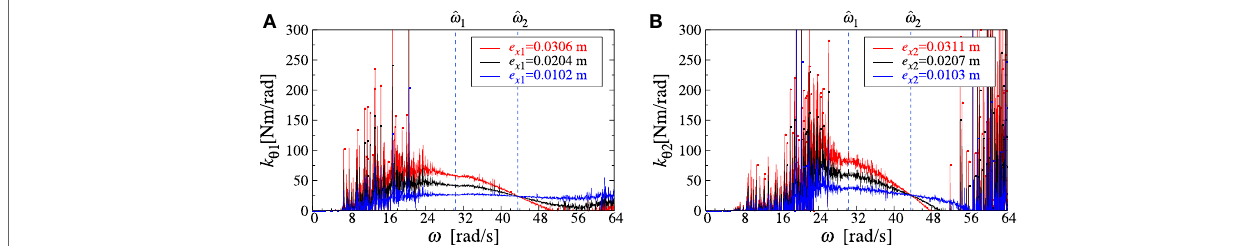
FIGURE 13 | Identification results of torsional stiffness, (A) first story, (B) second story.